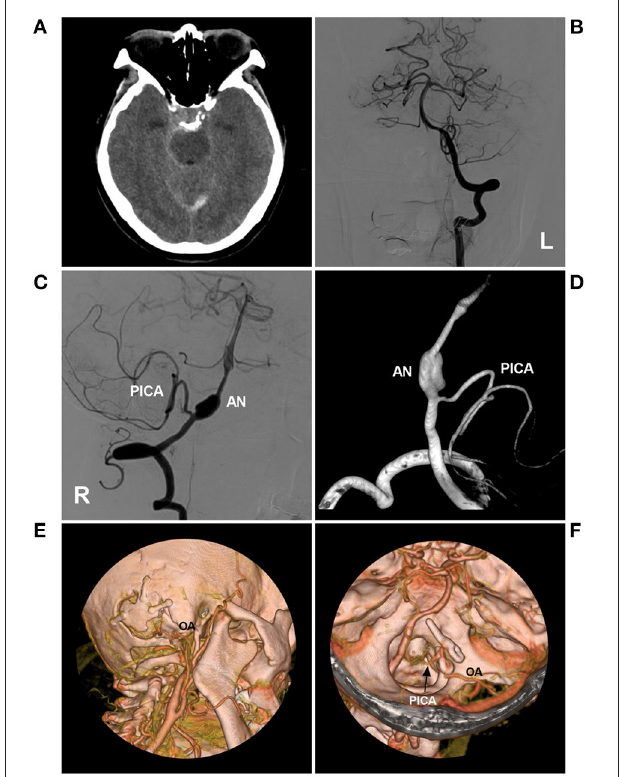
FIGURE 8 | Direct clipping of a fusiform AN of the MCA trunk. (A) MRI showed a fusiform low-signal lesion (arrow) in the Sylvian fissure. (B) CTA showed that the right AN was a fusiform without a neck (arrow). (C) The operative image before clipping revealed the AN, and a vein crossed the AN. (D) The operative image showed that the AN was clipped. (E) Fluorescence imaging showed that the proximal and distal MCAs were unrestricted. (F) Follow-up CTA showed that the AN (frame) was clipped completely. AN, aneurysm; CTA, computed tomography angiography; DSA, digital subtraction angiography; MCA, middle cerebral artery; MRI, magnetic resonance imaging; R,